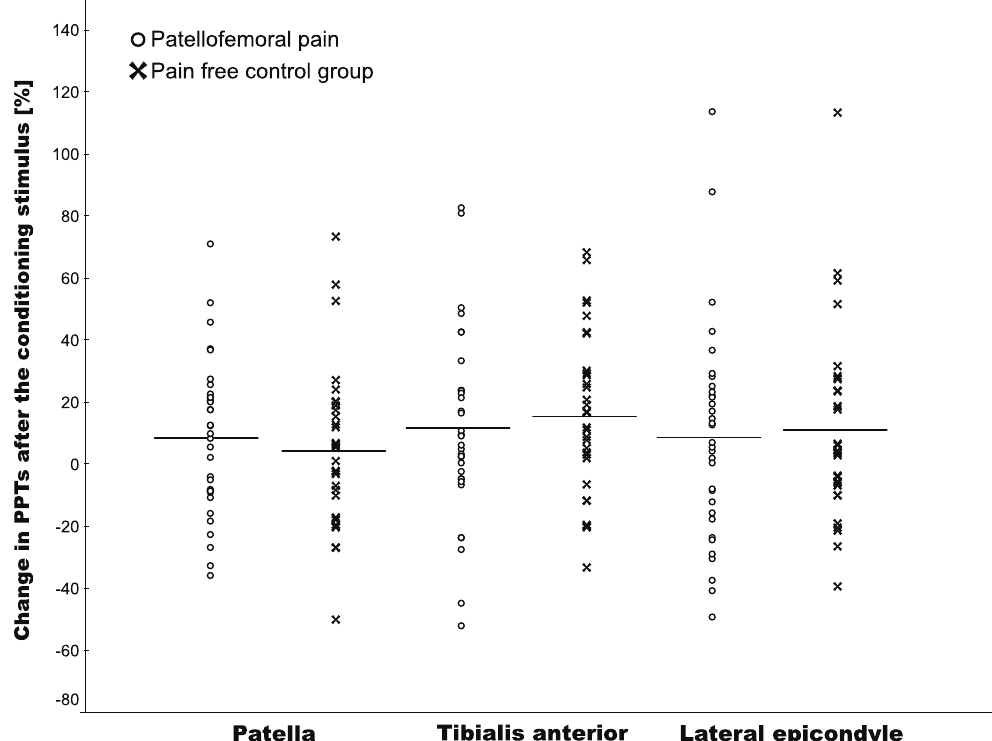
Fig 1. Percentage change in PPTs after the conditioning stimulus across the three test sites (individual patient data and group mean).